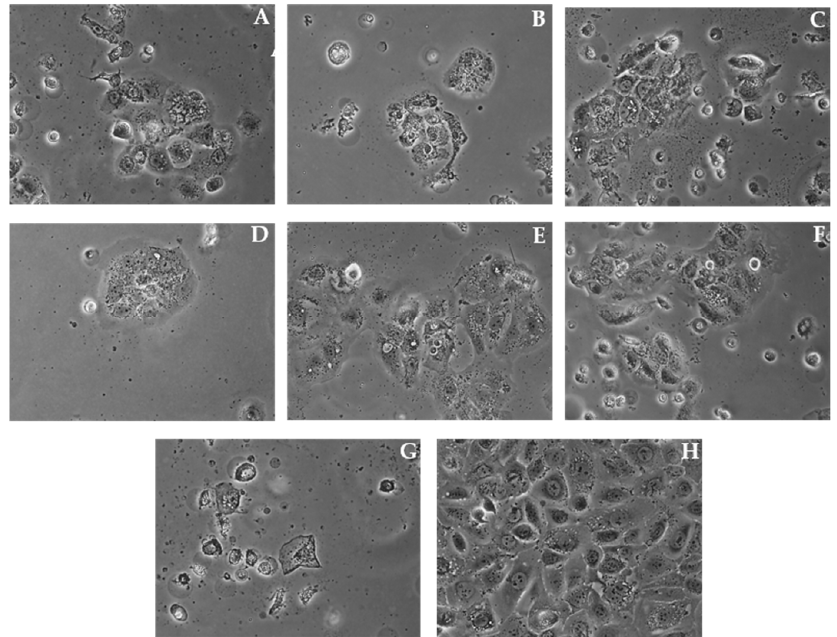
Figure 5. Morphological profile of SCC-25 cells after 48 h of incubation with HP1 ( A ), HP6 ( B ), and HP7 ( C ) at the concentration of 100 µg/mL and with 1 ( D ), 7 ( E ), ZAP ( F ), and cPT ( G ) at 100 µM concentrations compared to the untreated control cells ( H ).